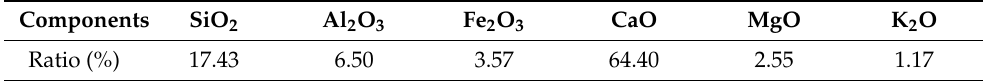
Table 1. Chemical composition of the cement used in this